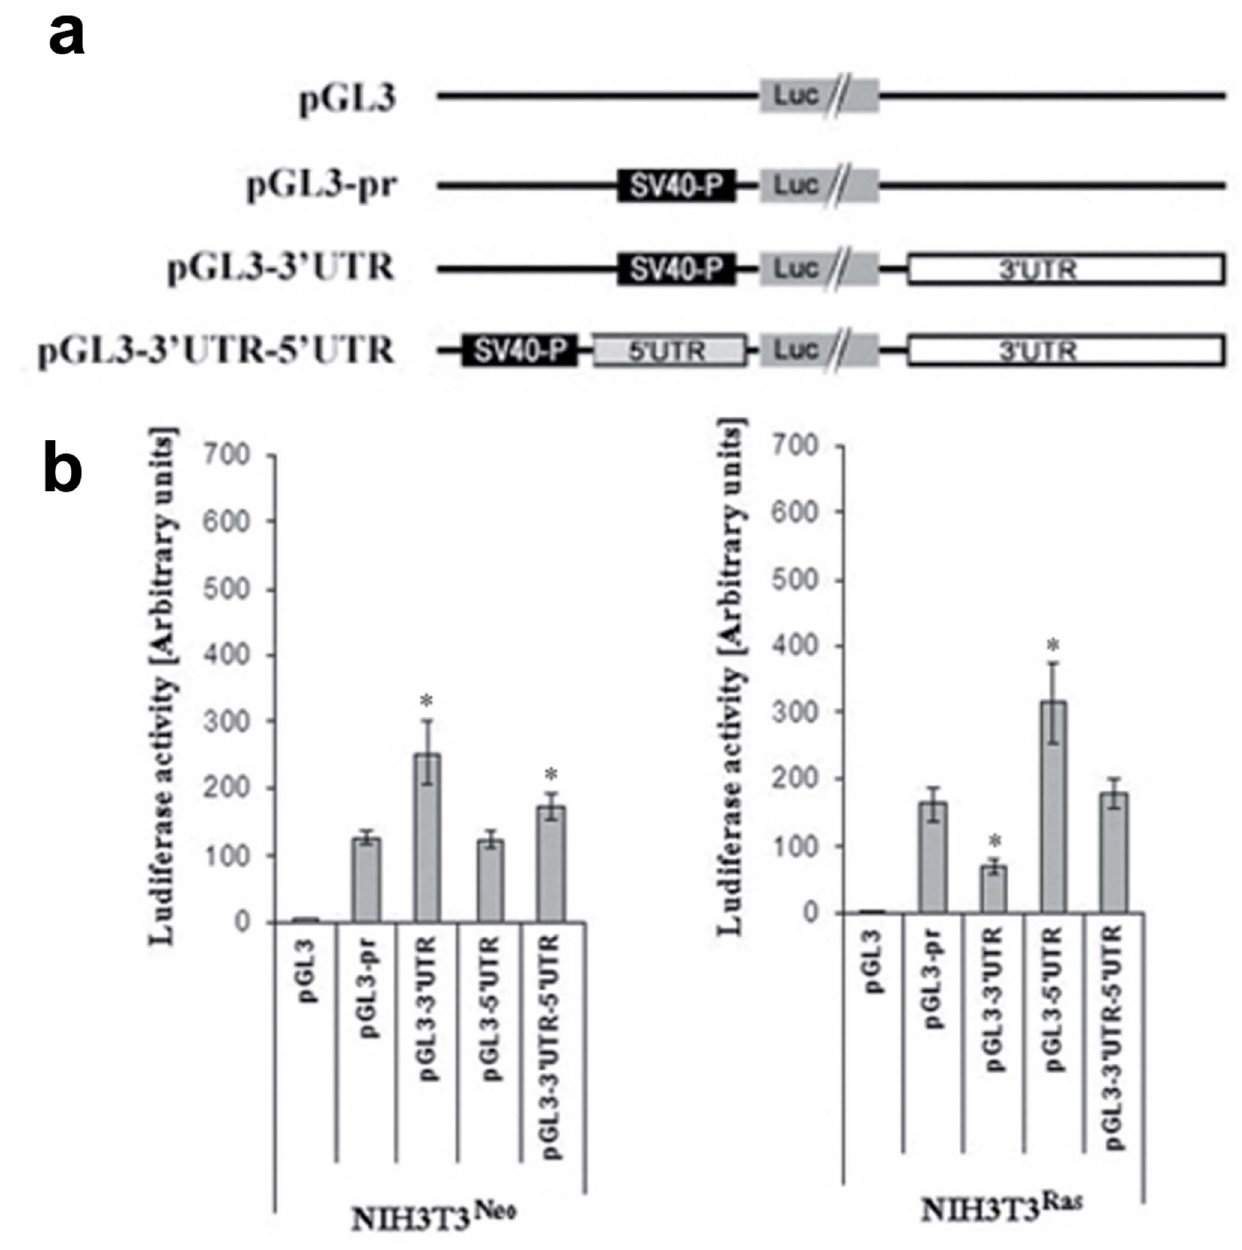
Figure 2. 3 9 and 5 9 UTRs-driven regulation in control versus Ras-overexpressing cells. a) Description of the different Cx43 mRNA 3 9 UTR and 5 9 UTR constructs used in this experiment. All constructs, except the pGL3 basic vector, contain the SV40 promoter (SV40-P) and the Luciferase coding region (pGL3-pr) in addition to the 3 9 UTR (pGL3-3 9 UTR) and/or the 5 9 UTR (pGL3-5 9 UTR) full length sequences. b) Luciferase assay using Cx43 mRNA 3 9 UTR and 5 9 UTR constructs in NIH3T3 Neo cells. The firefly luciferase activities were reported to the Renilla luciferase control values as explained in ‘‘Materials and Methods’’. The experiments were performed at least three times in quadruplicates (* p , 0.05).